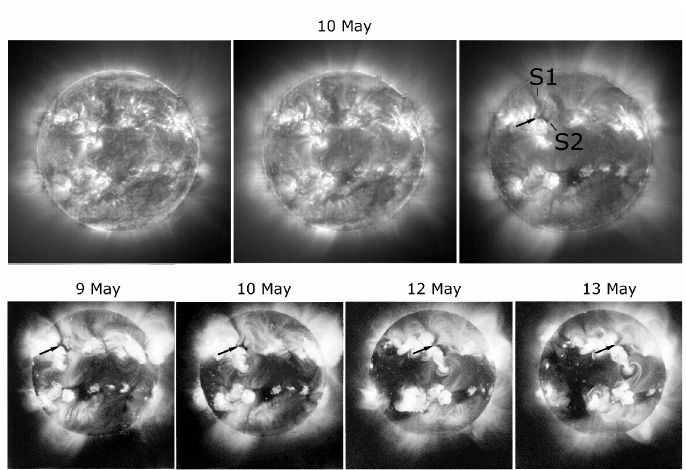
Fig. 5. EUV images in the 1.71 × 10 − 8 m, 1.95 × 10 − 8 m, and 2.84 × 10 − 8 m (from left to right in upper row) obtained with the SOHO EIT, and soft X-ray images obtained with the Yohkoh/SXT (lower row). The dark coronal structures S1 and S2 extend from the AR 8535 (arrow points to the site of the sunspot).